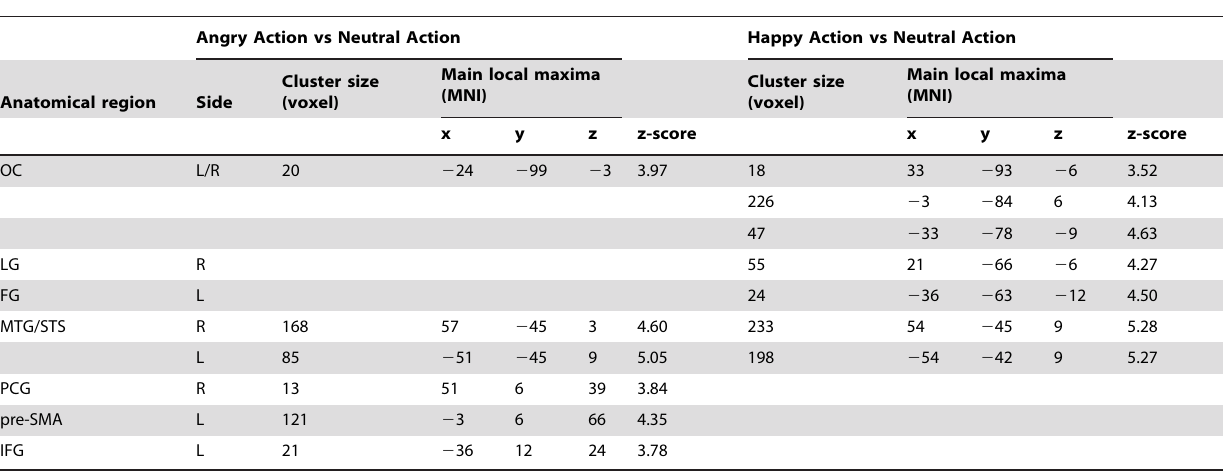
Table 2. Action-Emotion . Action